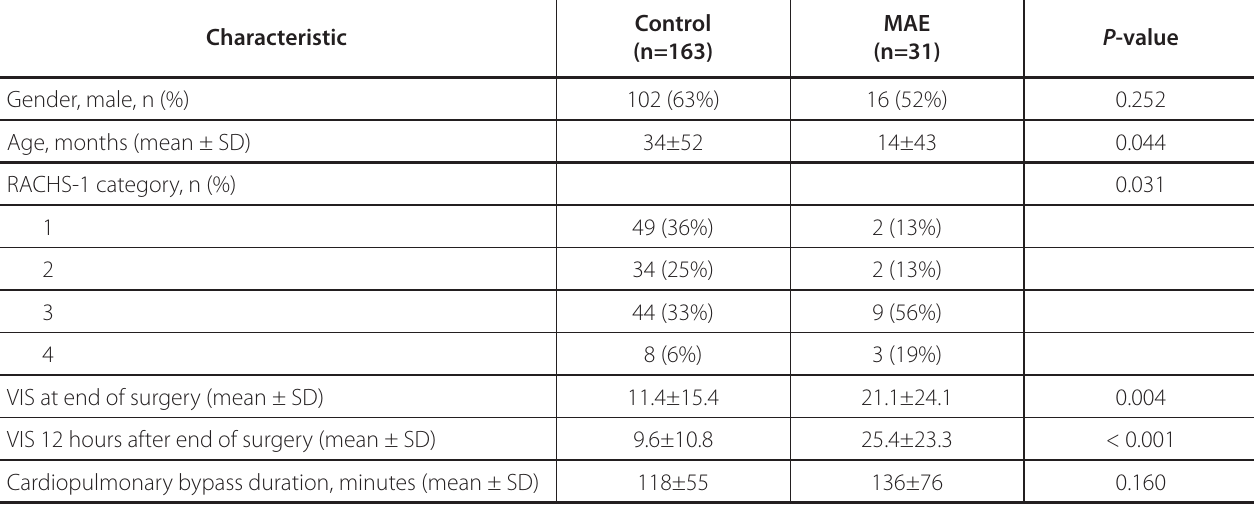
Table 1 . Demographic, clinical, and surgical characteristics of all included patients, according to the occurrence of a major adverse event (MAE) within 48 hours after surgery.